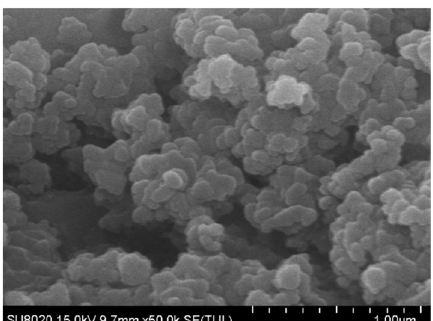
Figure 1: SEM image of NS particles precipitated by NS